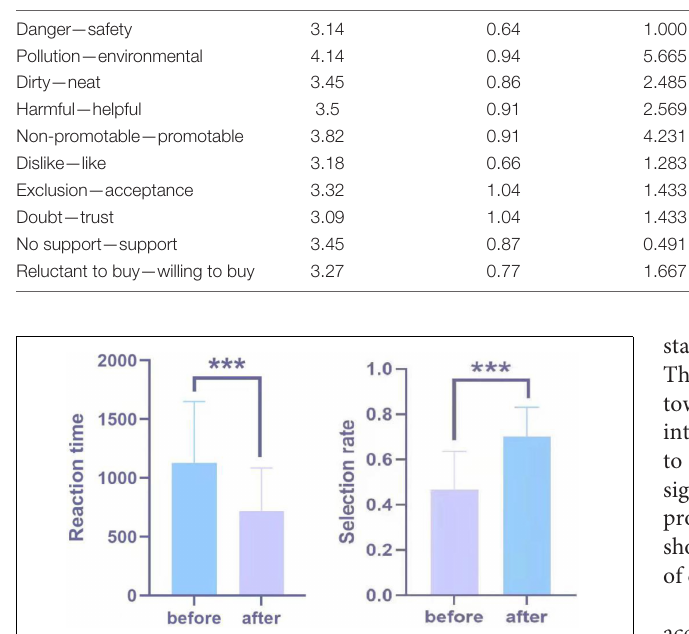
FIGURE 6 | Behavioral data significance graph. The asterisks indicate statistically significant differences (***0.001).